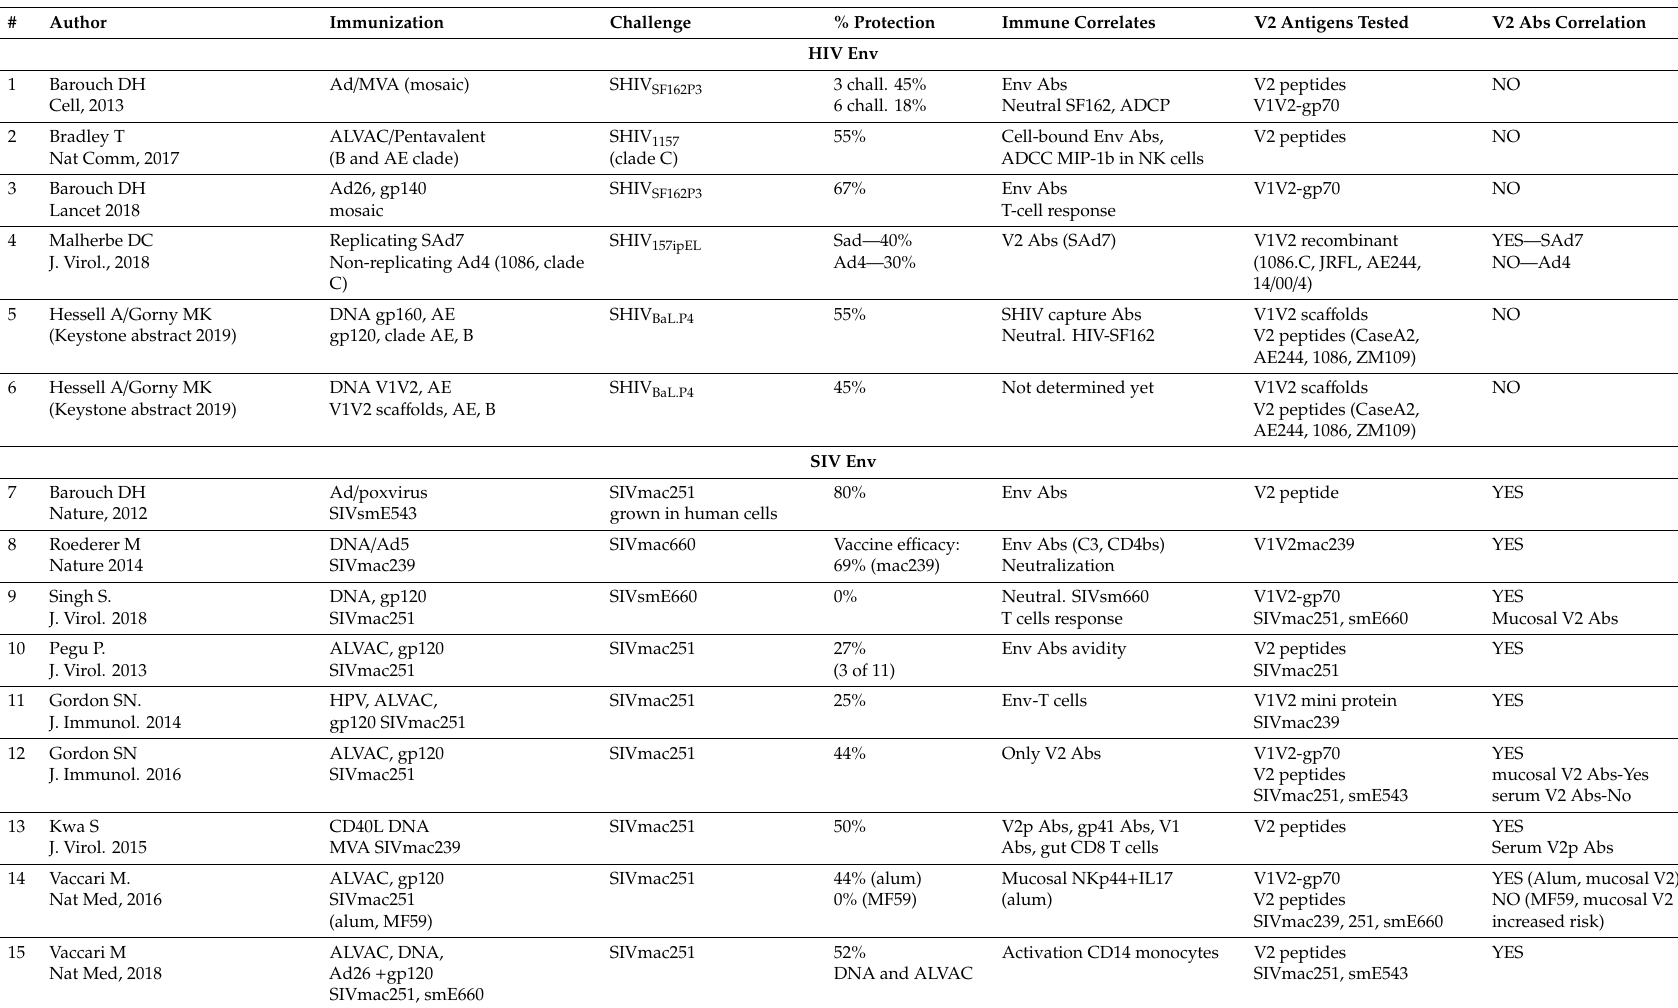
Table 3. Non-human primate vaccine studies with SHIV or SIV